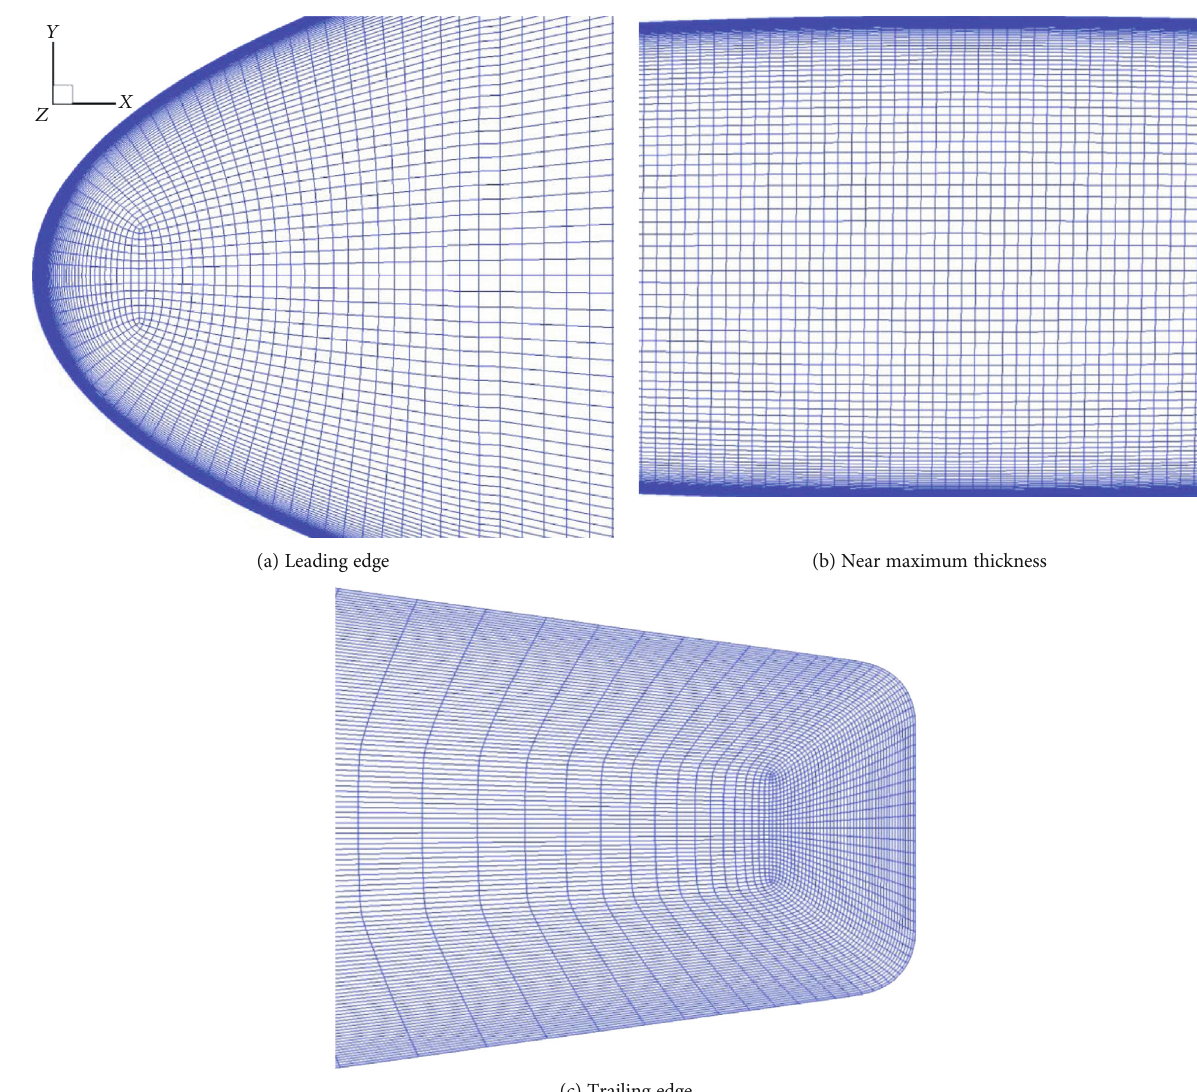
Figure 2: The spatial distribution of mesh at the wingtip.